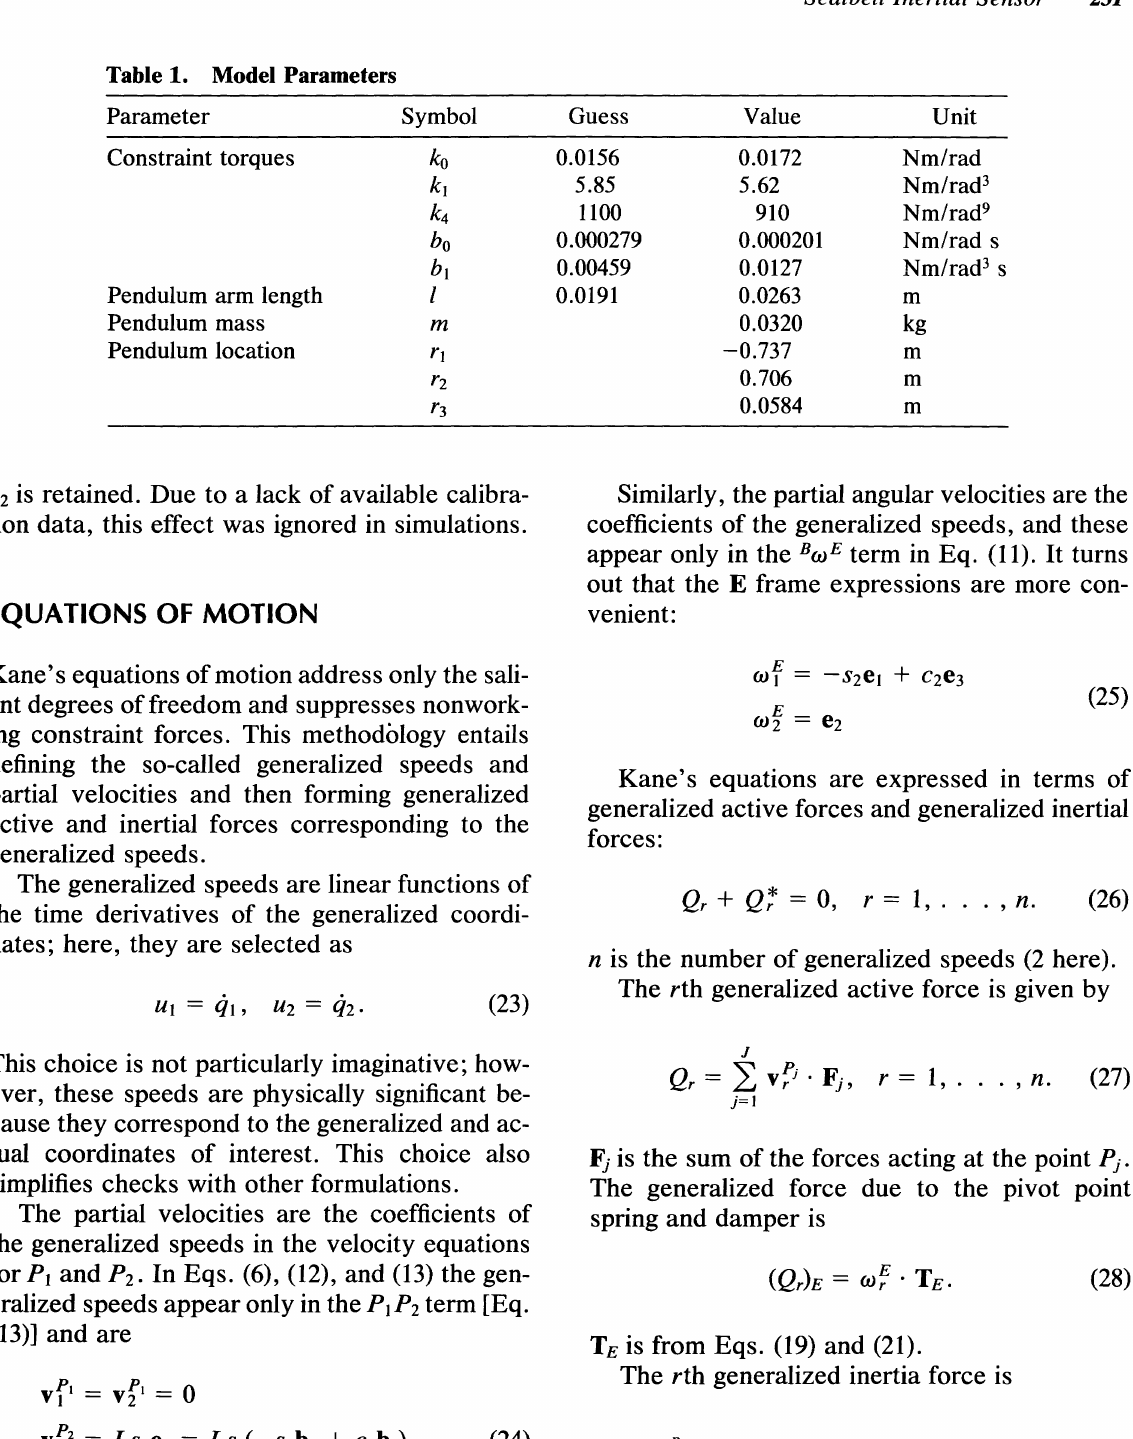
Table 1. Model Parameters Parameter